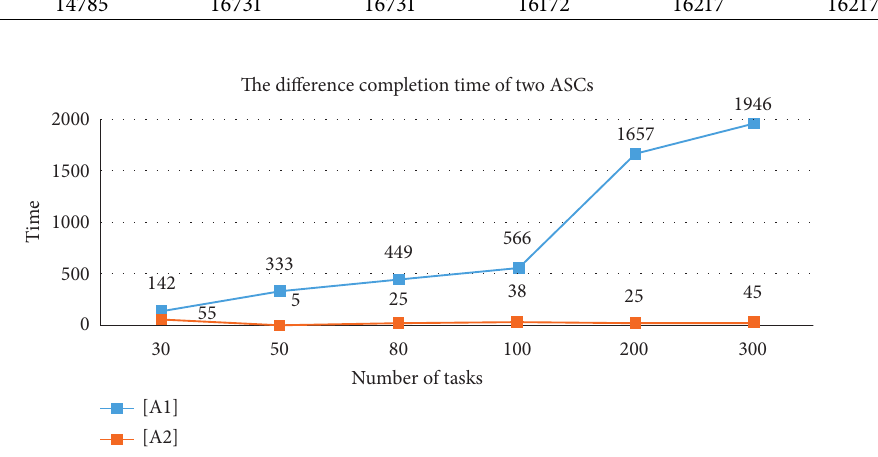
Figure 13: Difference completion time of two ASCs. Table 5: Sensitivity test